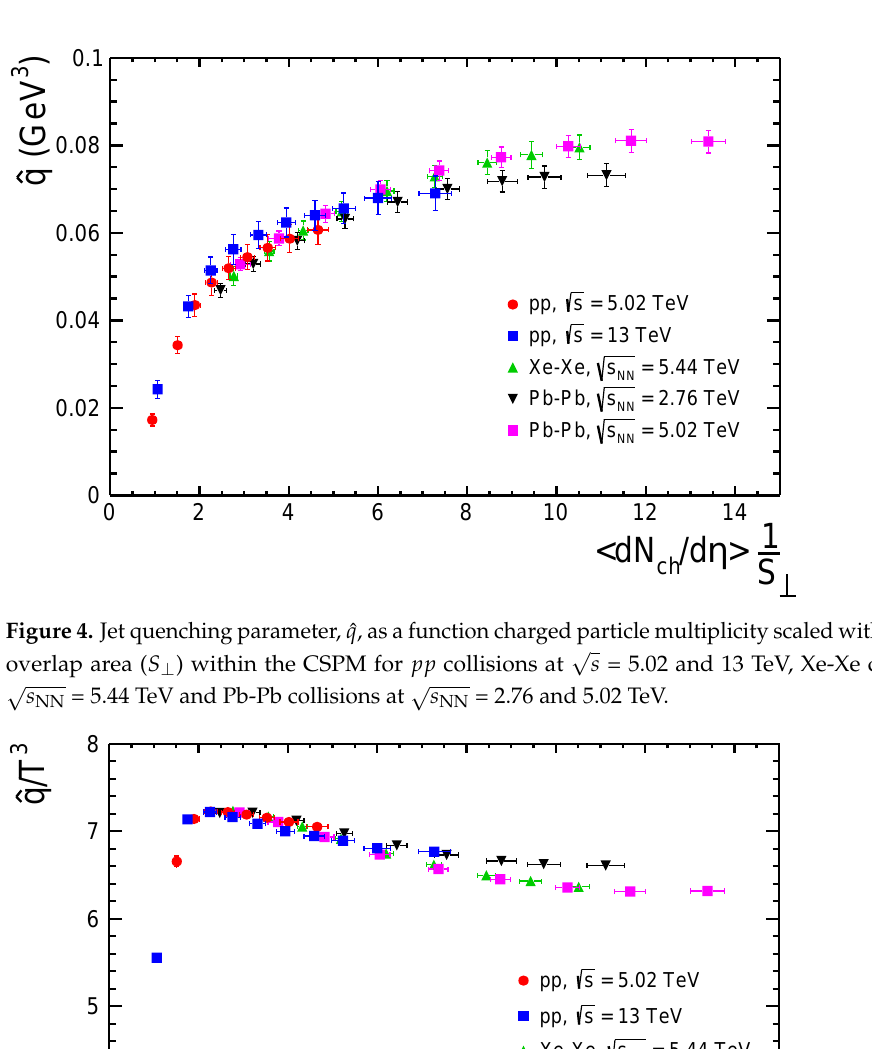
Figure 5. ˆ q / T 3 vs. charged particle multiplicity, scaled by S ⊥ , for pp collisions at 13 TeV, Xe-Xe collisions at